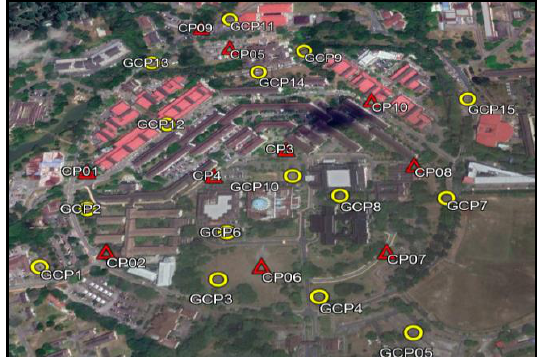
Figure 3. Flowchart of methodology in this study Figure 2: Location of GCPs (yellow circle) and CPs (red